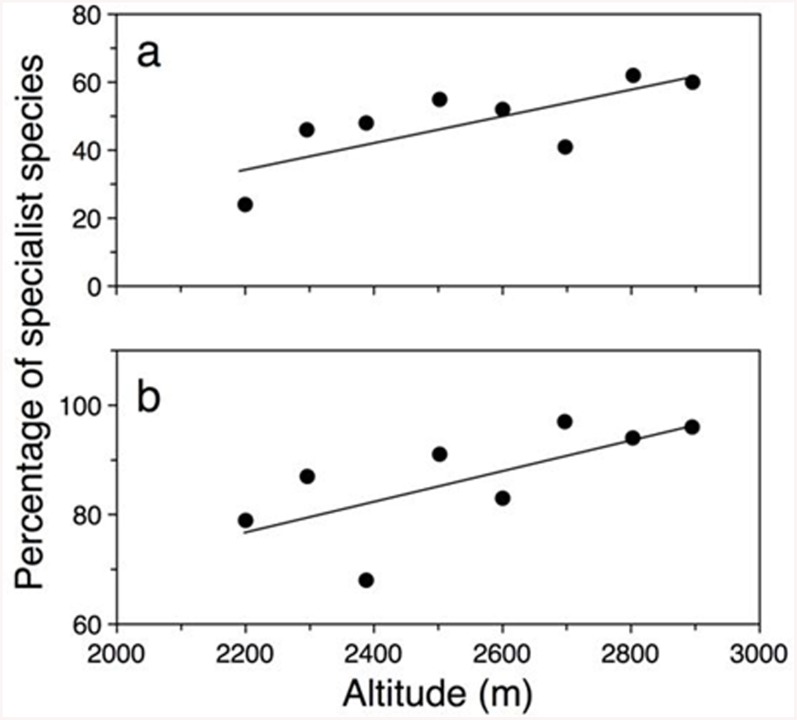
Relationship between altitude and percentage of specialist species.The number and percentage of specialist species was estimated for each altitude. a) Flowering plant species and b) flower-visitors. Equations: % specialist P = -0.44 + 0.0003 altitude; % specialist A = 0.15 + 0.0002 altitude.